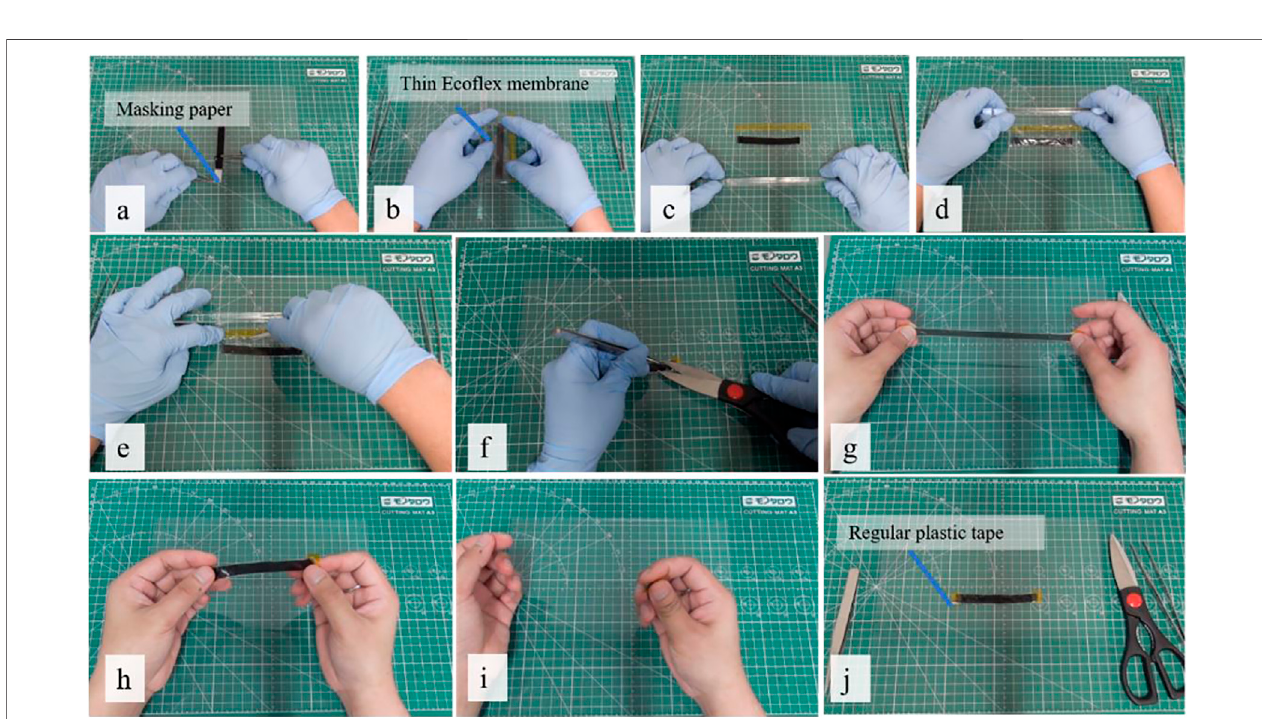
FIGURE 5 | Sensor lamination process using a thin Eco fl ex membrane.